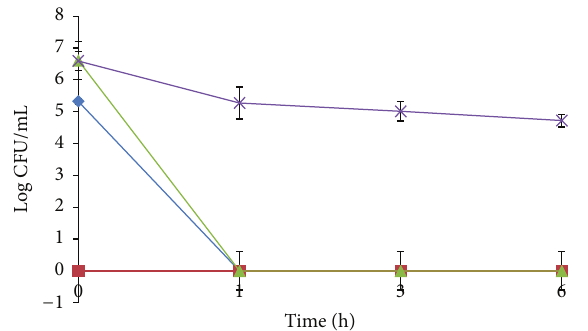
Figure 3: Survival of V. cholerae in sterile distilled water as control ( Q ), plain tea ( ◼ ), tea with sugar ( 󳵳 ), and tea with condensed milk ( × ). Each point is the mean of four replicate